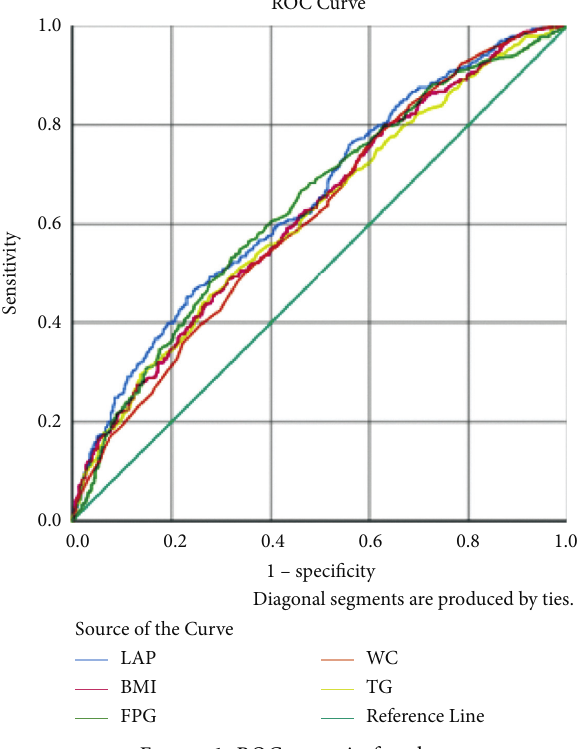
Figure 1: ROC curve in female.